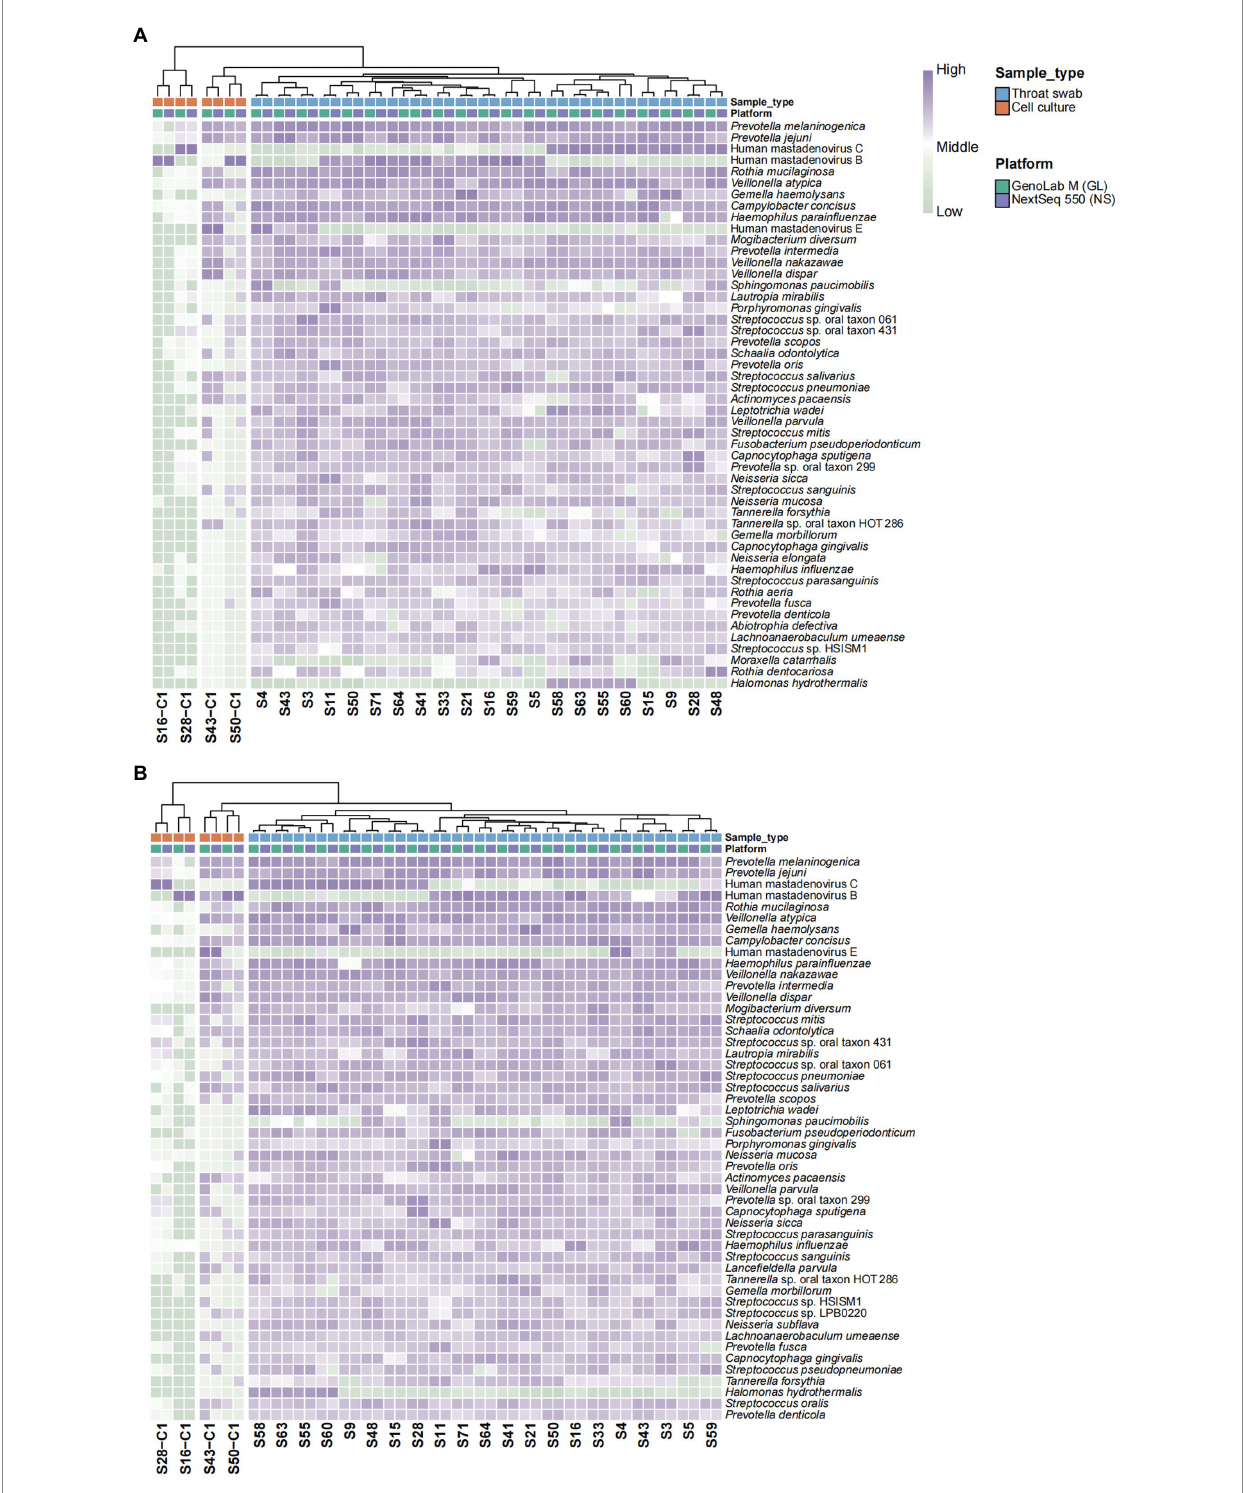
FIGURE 1 Heat map showing abundance clustering of the top 50 species. (A) SE150 and (B) SE75 sequencing mode. Z values represent the corresponding value of the heat map, which were obtained after normalization to the relative abundance of the species in each row. The color gradient from green to purple indicates low to high relative abundance. The x-axis displays the samples and groups and the y-axis represents the species annotation information. Horizontal clustering indicates the similarity of species richness in different